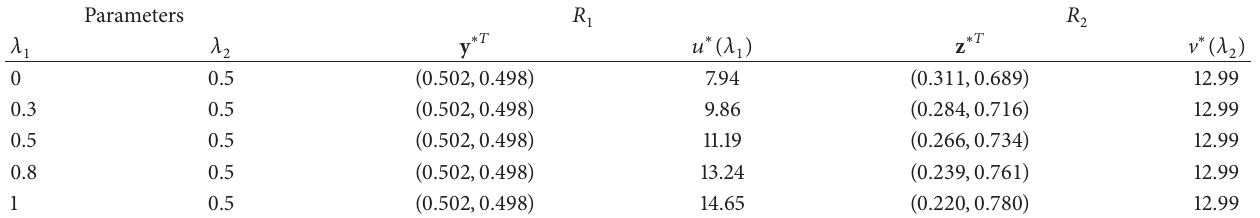
Table 5: Satisfying Nash equilibrium values and corresponding strategies of commerce retailers.